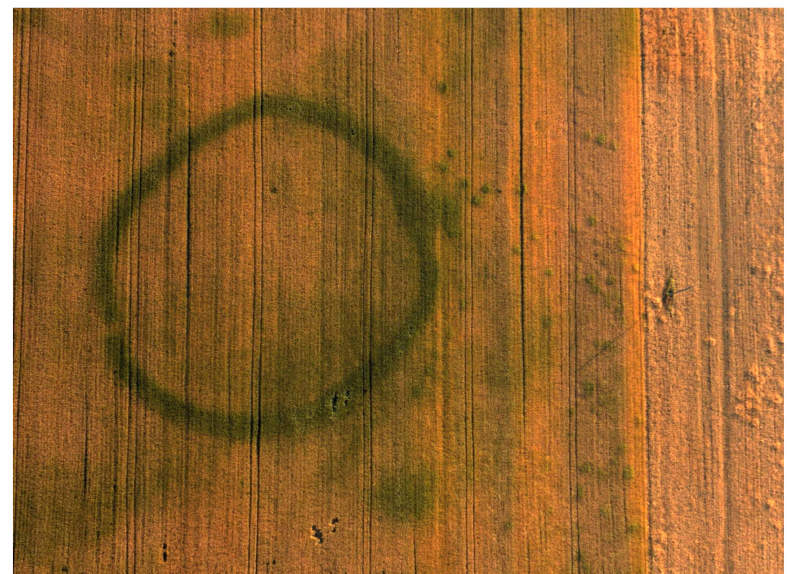
Figure 1. Dabas—Öreg Orsz á g ú ti-d˝ul˝o (Pest County, Hungary) aerial archaeological site. The image is dominated by the positive cropmarks showing the color variations (marks of a green circular ditch and small pits) in yellow wheat. On the right side, mostly due to the barley’s late harvest period, some further pits are visible (cf. Figure 2) owing to shadow effect of the cropmarks (Oblique aerial photograph, 12 June 2015, Zolt á n